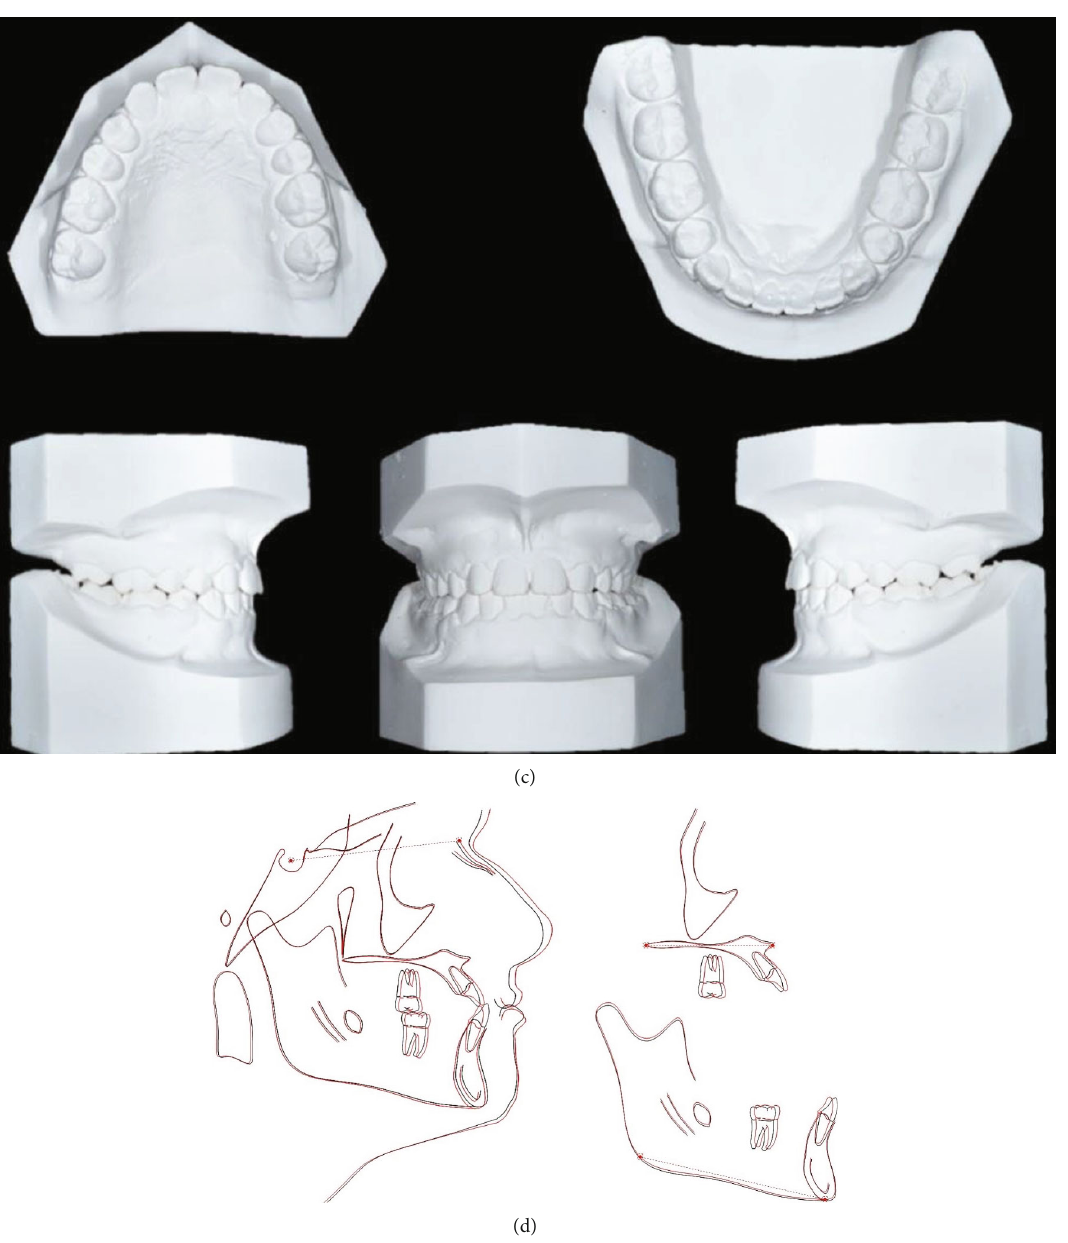
Figure 5: Posttreatment cephalometric radiograph, panoramic radiograph, study models, and superimposition: (a) cephalometric radiograph, (b) panoramic radiograph, (c) study models, and (d) cephalometric